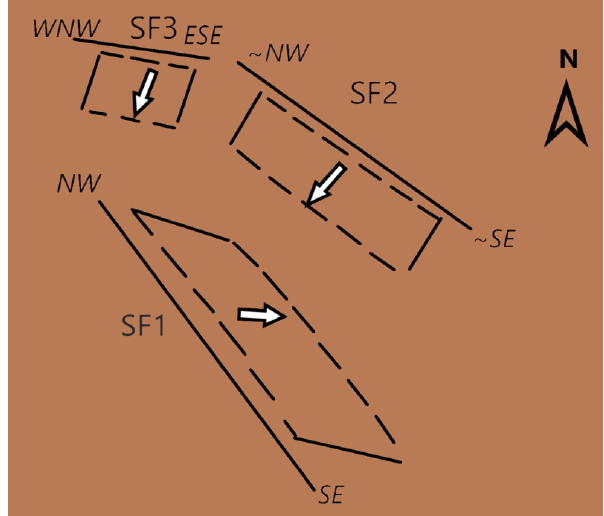
Figure 24. Not-in-scale 3D cartoon that illustrates the three normal seismic fault (SF) segments that activated with the earthquakes of the 3 (SF1), 4 (SF2) and 12 March (SF3)